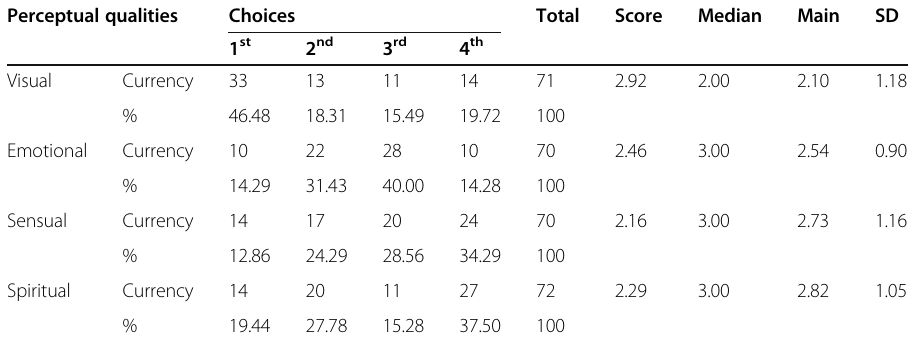
Table 1 The rank of the most important qualities for the respondents Perceptual qualities Choices Total Score Median